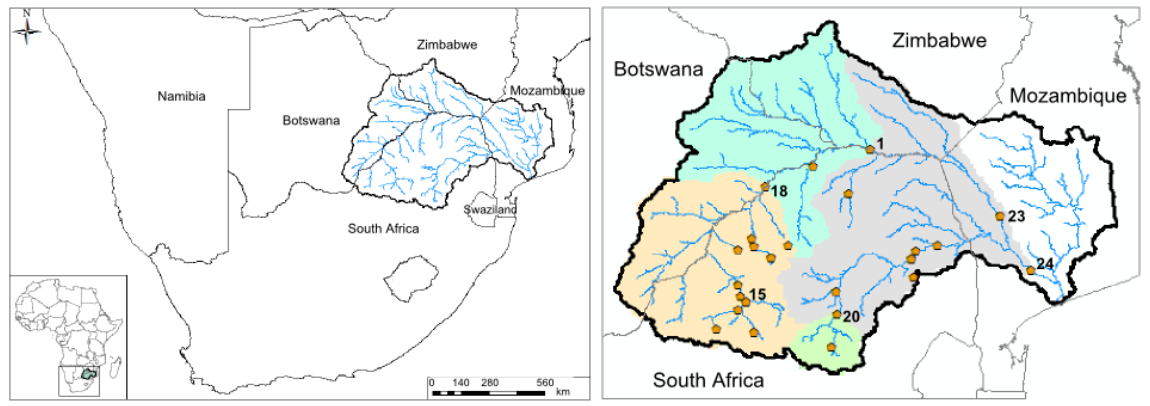
Figure 1. Limpopo River basin: the location of the basin (left panel) and the locations of hydrometric stations (right panel). Selected stations (nos. 1, 15, 18, 20, 23 and 24) are highlighted. The subbasins draining to each hydrometric station are named after the station number.